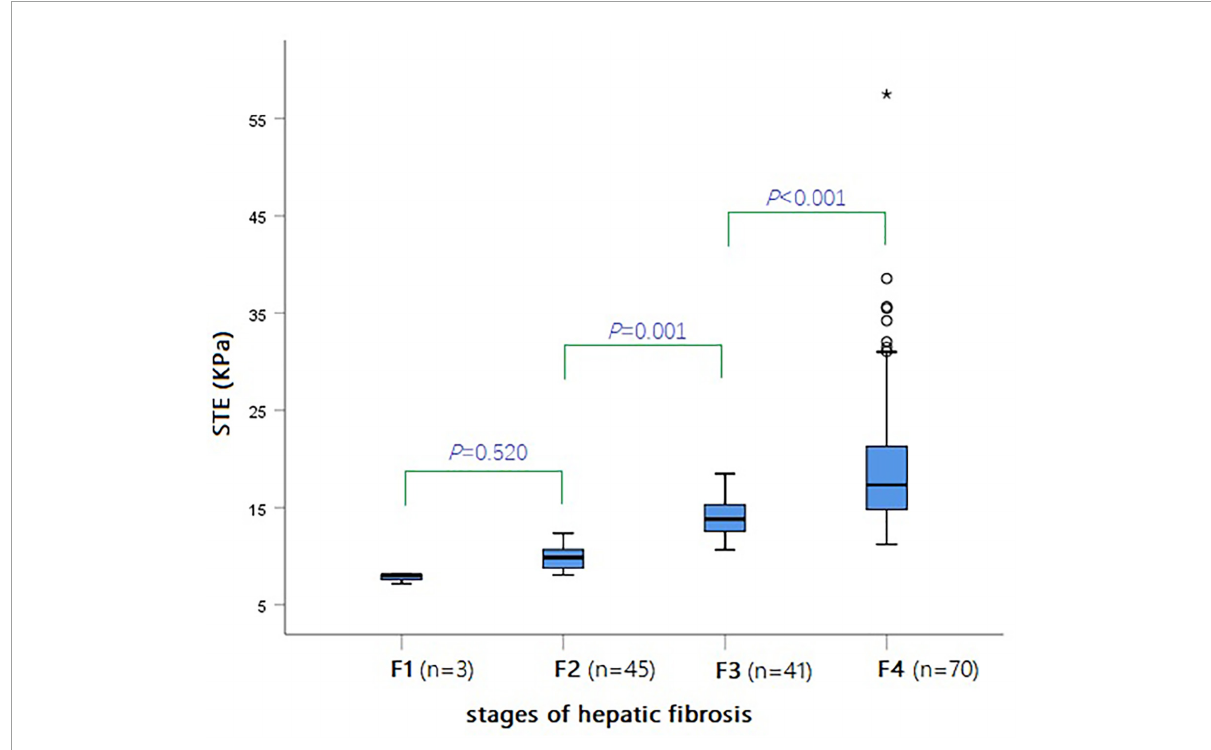
FIGURE5 Box-and-whisker plot showing the STE values (KPa) for various stages of hepatic fibrosis in all BA patients.